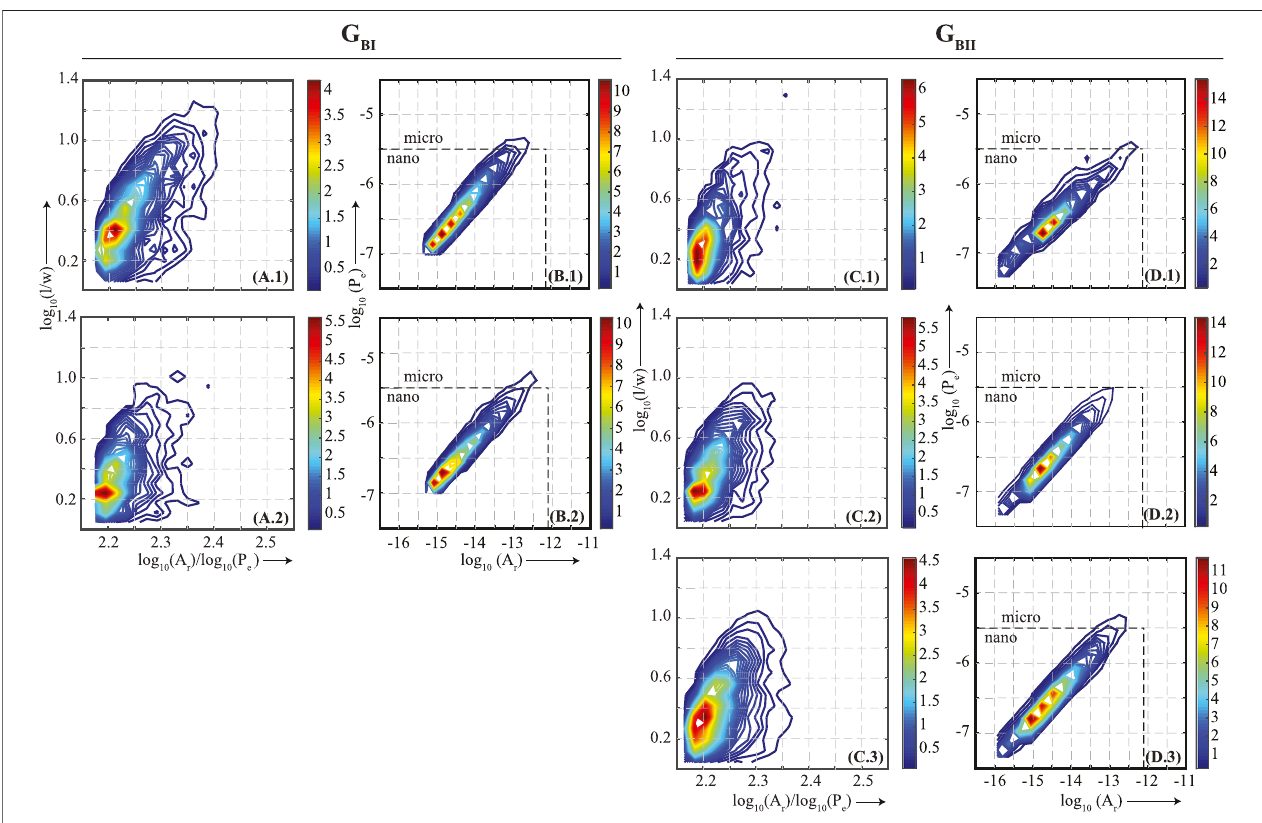
FIGURE6 | Facies B . Symbols and labels are thesameasin Figure 5 . Sample depth, porosity, compositionand gradients for P-(r P ),S1-(r S1 ) and S2-(r S2 ) waves are mentioned in the Table 2 . The fi gure indicates that within the same pore-shape distribution, r P increases as the dominant pore-size decreases.